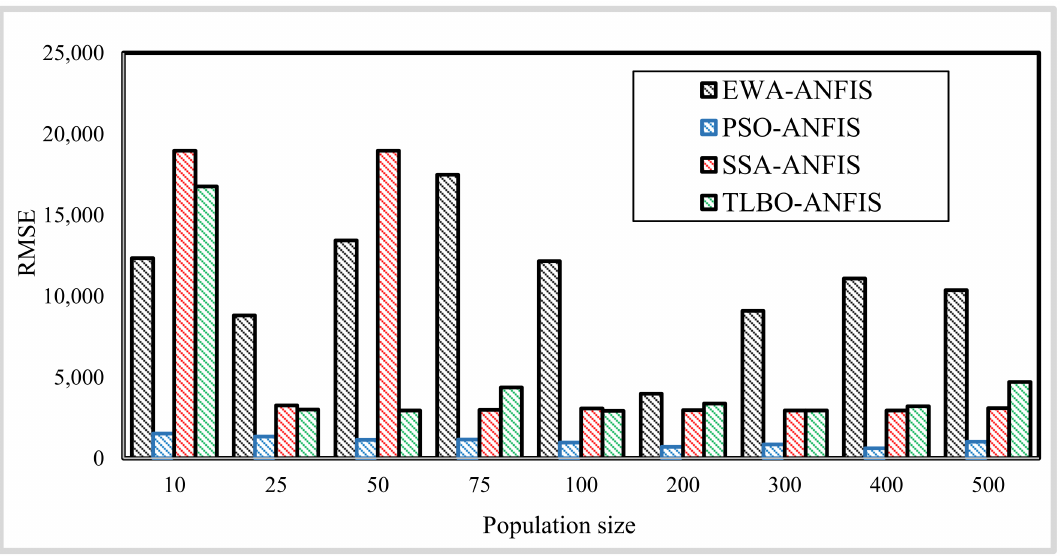
Figure 2. The trial-and-error results for selecting the best population